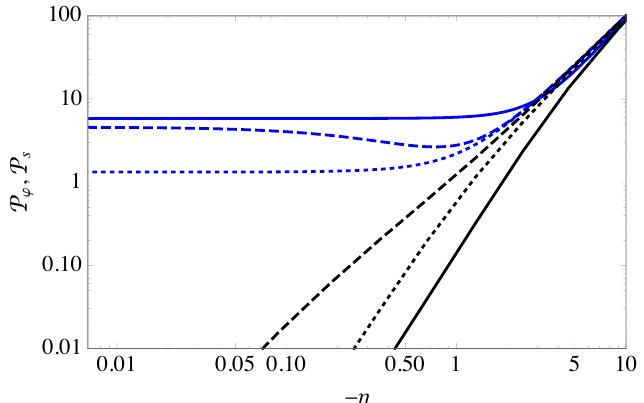
Figure 2 . Power spectrum of the (cid:25) and s (cid:12)elds in the unit of H 2 = 2 k 3 . The solid, dotted, and dashed curves are for ( (cid:22)=H; m=H ) = (10 ; 2) ; (1 ; 2) and (1 : 2 ; 0 : 9),